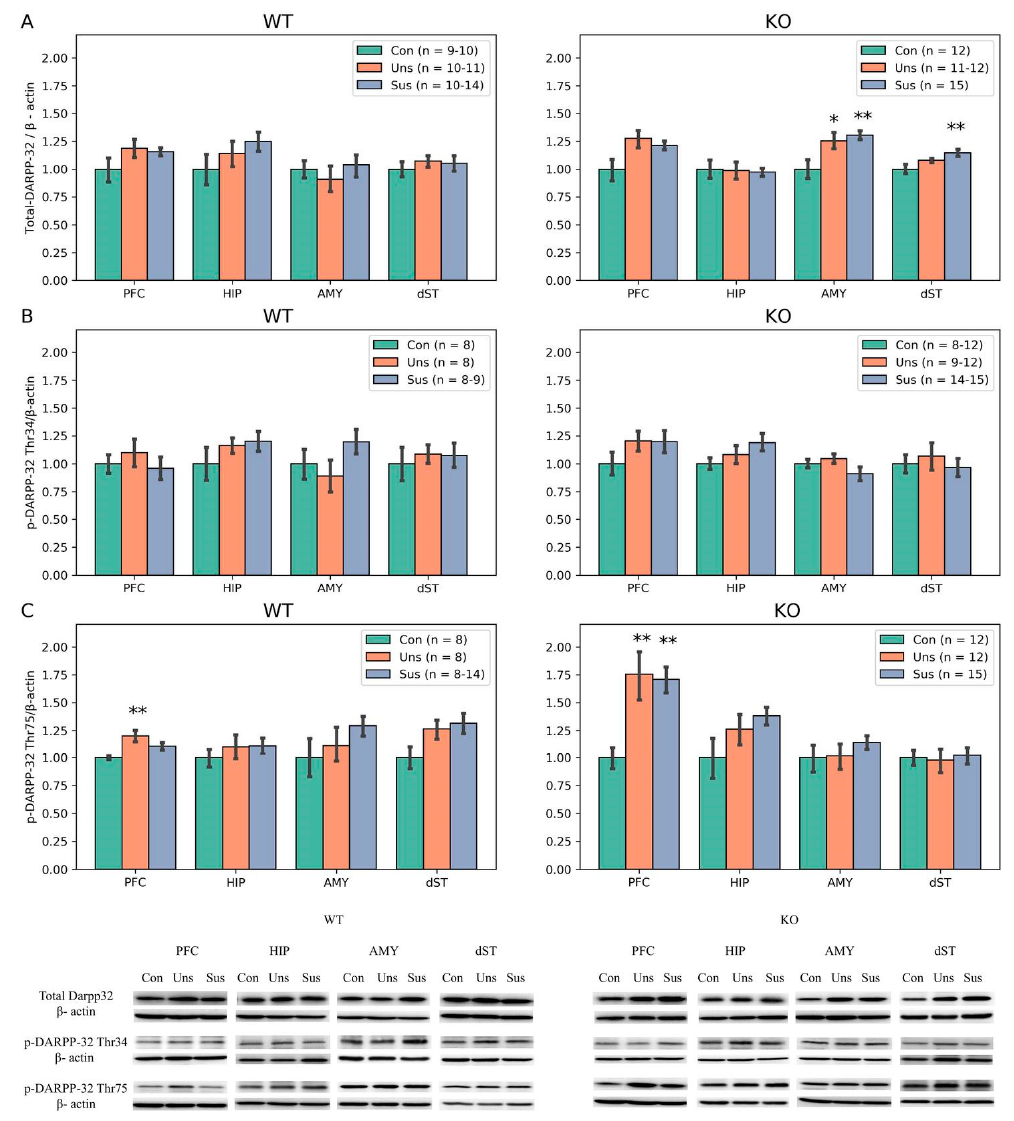
Figure 7. Western blot results of DARPP-32 among three groups in STMN KO and WT mice. ( A ) Total DARPP-32: expression levels of total DARPP-32 in the PFC, HIP, AMY and dST of WT and KO mice; ( B ) pDARPP-32 Thr34: expression levels of pDARPP-32 Thr34 in the PFC, HIP, AMY and dST of WT and KO mice; and ( C ) pDARPP-32 Thr75: expression levels of pDARPP-32 Thr75 in the PFC, HIP, AMY and dST of WT and KO mice. * p < 0.05, ** p < 0.01 compared to control group; Con, Control; KO, Knock Out; Sus, Susceptible; Uns, Unsusceptible; WT, Wild-Type.